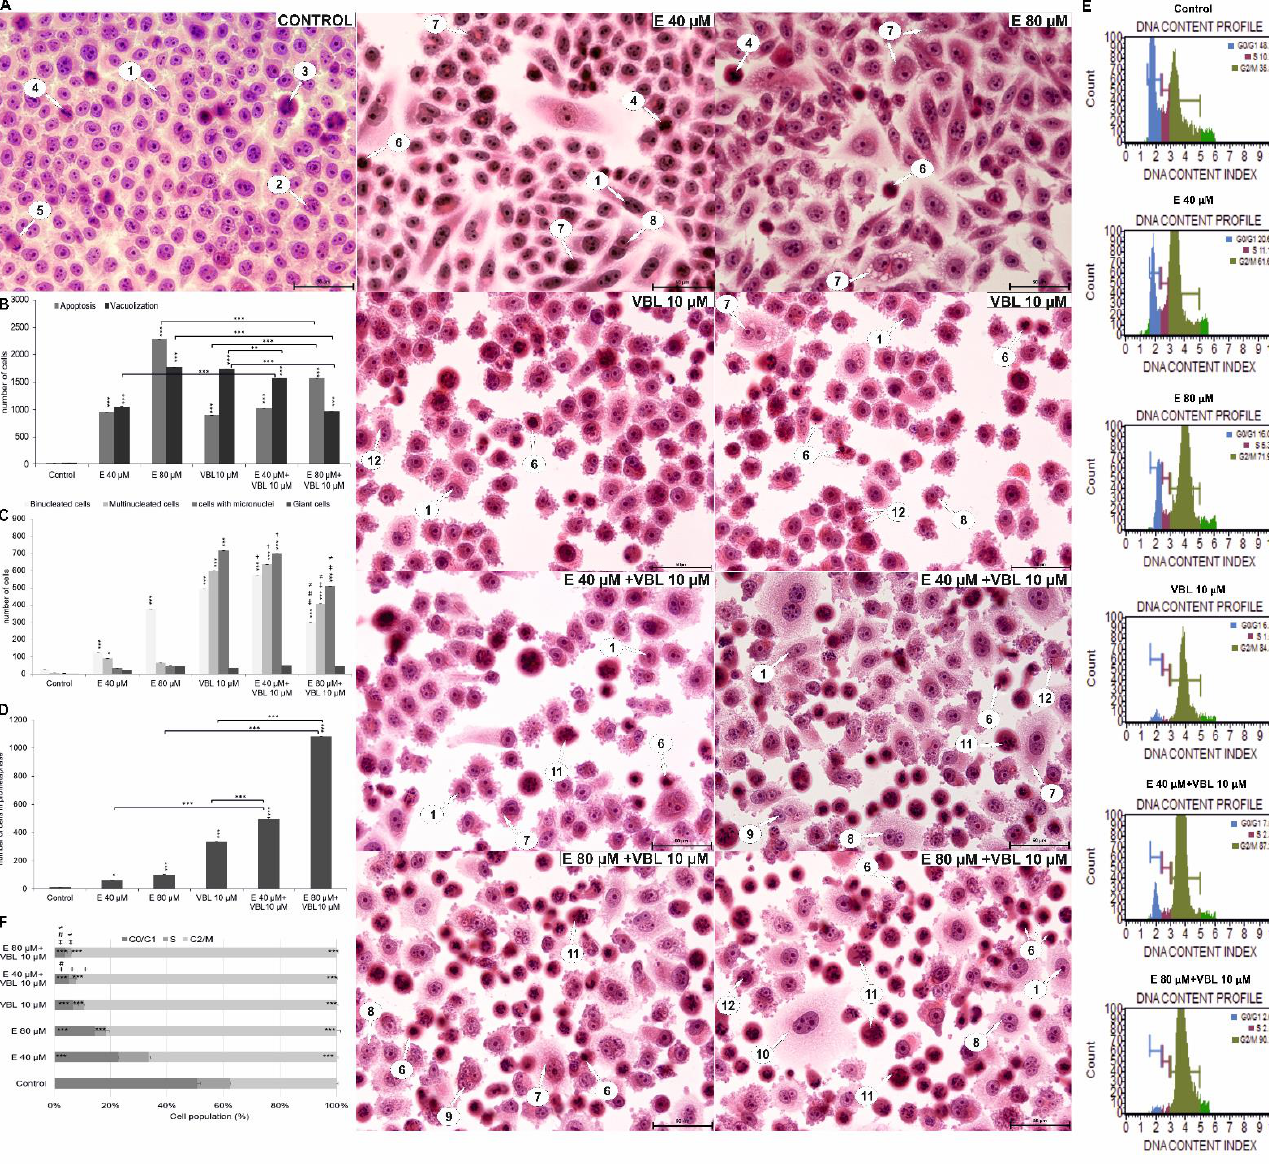
Figure 8. Morphological changes and changes in the cell cycle in Hela cells treated with emodin, vinblastine and their combined effects. ( A ) Cells stained with hematoxylin and eosin (H&E method). Control: cells in interphase and during cell division. Emodin 40 and 80 µM: numerous cells with cytoplasmic vacuolization, binuclear cells, multinucleated cells, and apoptotic cells. Vinblastine 10 µM: a large number of cells with micronuclei and cells with a disturbed formation of chromosomes. Combined action of emodin (40 and 80 µM) and vinblastine (10 µM): very numerous polynuclear cells, cells with micronuclei and cells with condensed chromosomes dispersed in the cytoplasm. 1 — interphase; 2 — prophase; 3 — prometaphase; 4 — metaphase; 5 — telophase; 6 — apoptosis; 7 — vacuolization; 8 — binuclear cells; 9 — polynuclear cells; 10 — giant cells; 11 — cells with abnormal chromosome segregation; 12 — cells with micronuclei. Magnification × 400. Comparison of the number of apoptotic cells and cells with cytoplasmic vacuolization ( B ) and indicators of mitotic catastrophe ( C ), i.e. , the number of binucleated, multinucleated, giant cells and cells with micronuclei of HeLa line after 24 h of exposure to emodin (40 and 80 µM), vinblastine (10 µM), and their combined action (E 40 and 80 µM + 10 µM VBL). The symbol † represents statistically significant change ( p < 0.0001) with emodin at a dose of 40 µM compared to cells treated by the combined action of emodin (40 µM) and vinblastine at a dose of 10 µM. The symbol ‡ represents statistically significant change ( p ≤ 0.0001) with emodin at a dose of 80 µM compared to cells treated with the combined action of